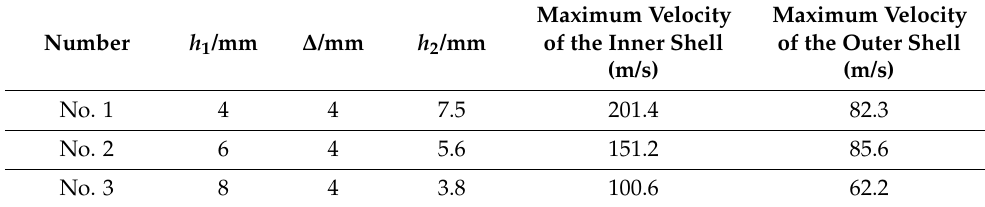
Figure 7. Photographs of double-layer steel cylinders after cutting. ( a ) Double-layer shells after cut- ting. ( b ) Inner shell after cutting. ( c ) Outer shell after cutting.